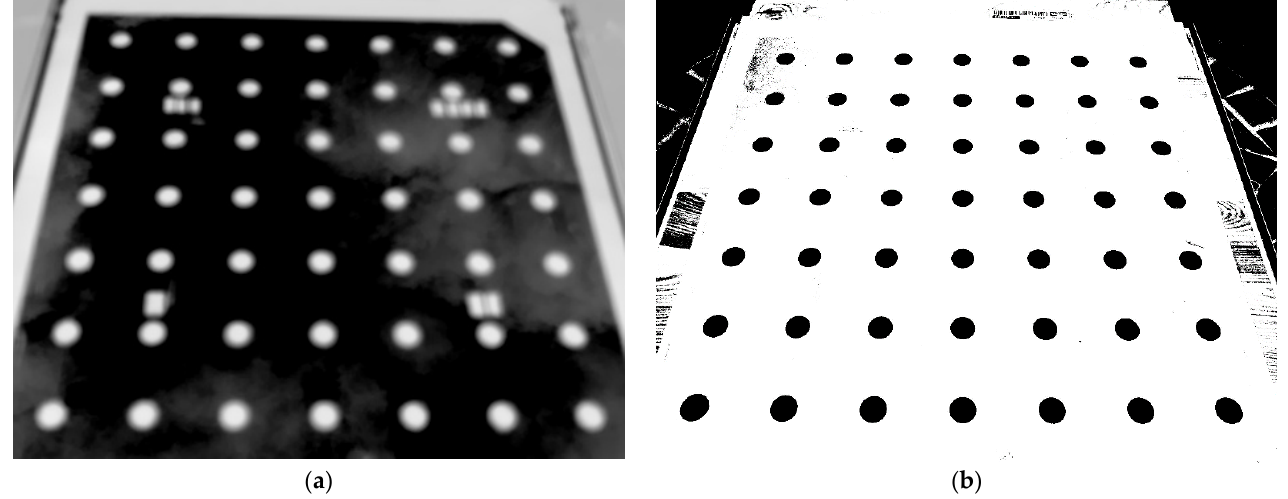
Figure 9. Images for camera calibration using plane calibration field: ( a ) TIR image; ( b ) RGB image.